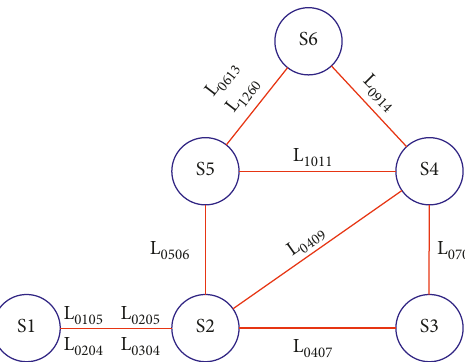
Figure 6: (a) The DST; (b) the segmentation result.